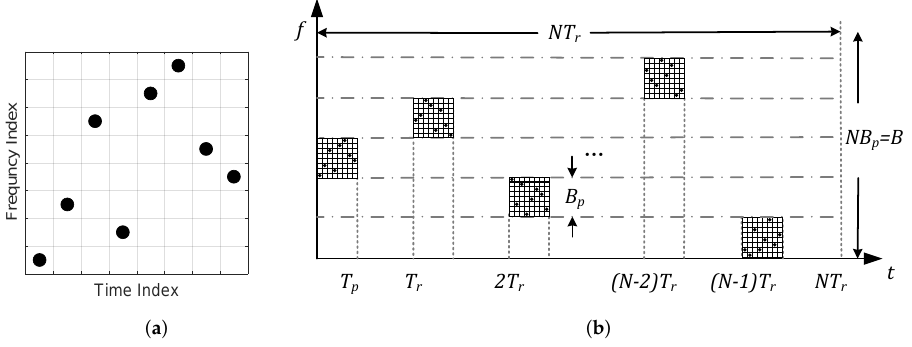
Figure 1. RSF-DC-DFC Wavefrom diagram: ( a ) a Costas array of order 8; ( b ) TF characteristics of the RSF-DC-DFC Wavefrom.